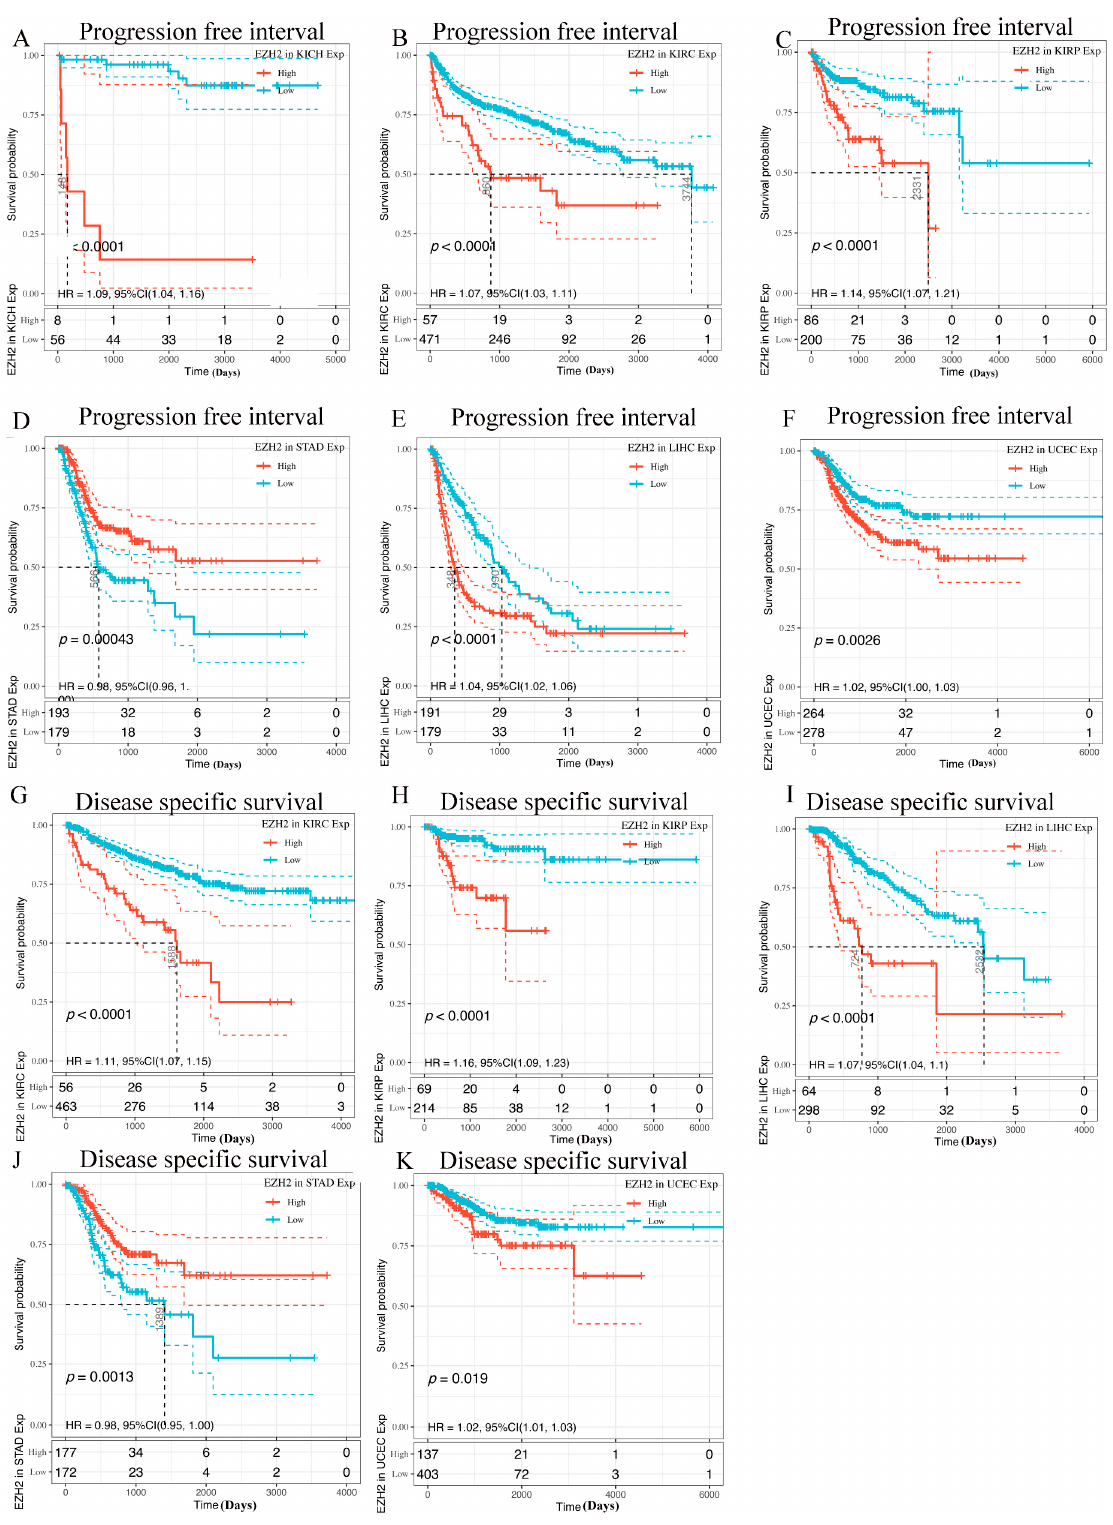
Figure 4. Kaplan-Meier survival curves of human cancers with high and low EZH2 expression analyzed by the GEPIA2 and Sangerbox databases. ( A – F ) Progression-free interval (PFI). ( G – K ) Disease-specific survival (DSS).